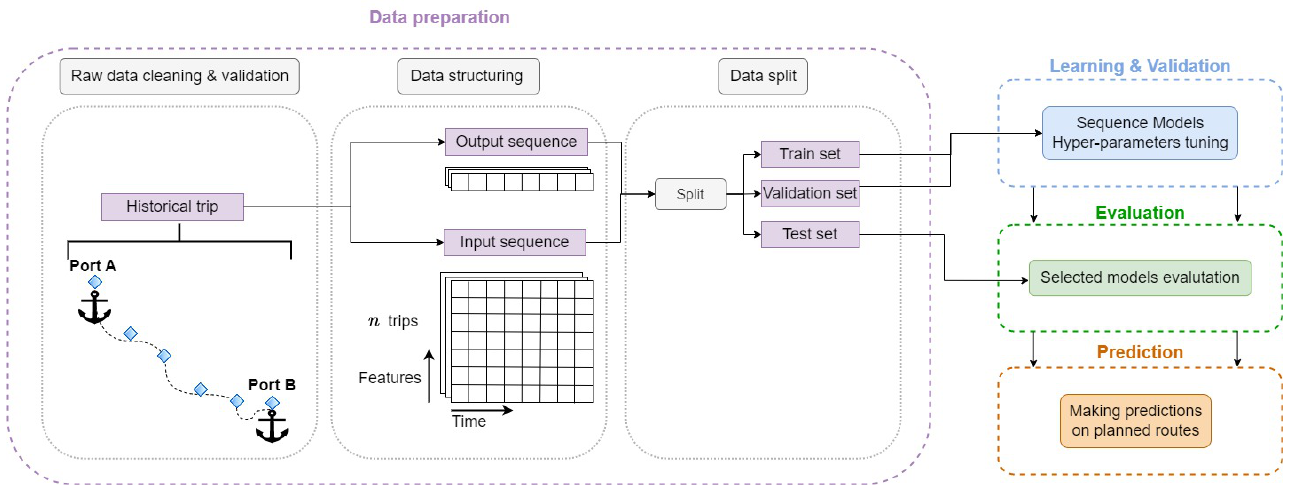
Figure 2. Overview of the methodology for ship speed